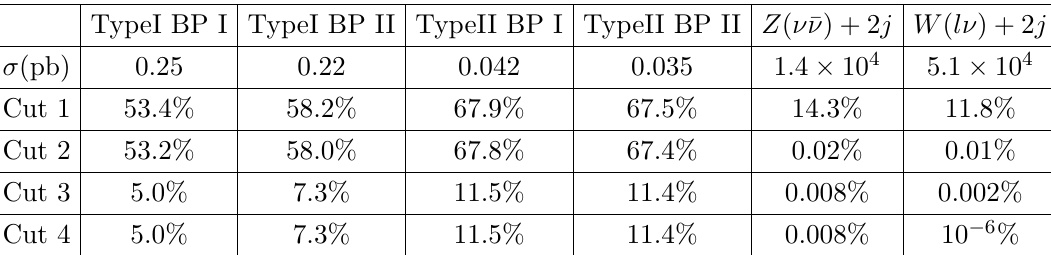
Table 5 . Signal and background e(cid:14)ciencies after applying various cuts for the vector boson fusion production channel at 14 TeV. The cross sections are calculated at